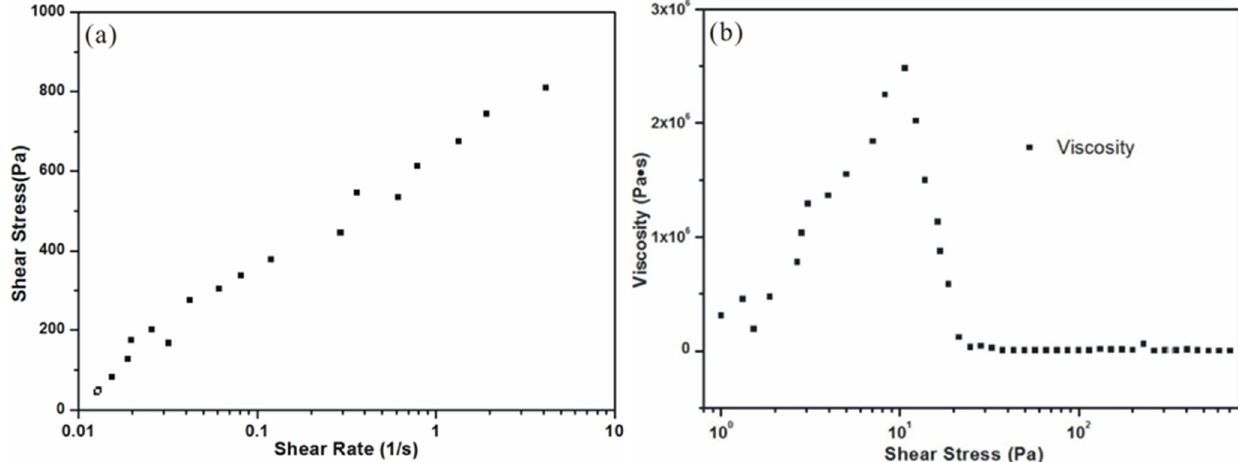
Figure 3. ( a ) Plot of the shear stress as a function of shear rate; ( b ) plot of the viscosity as a function of shear